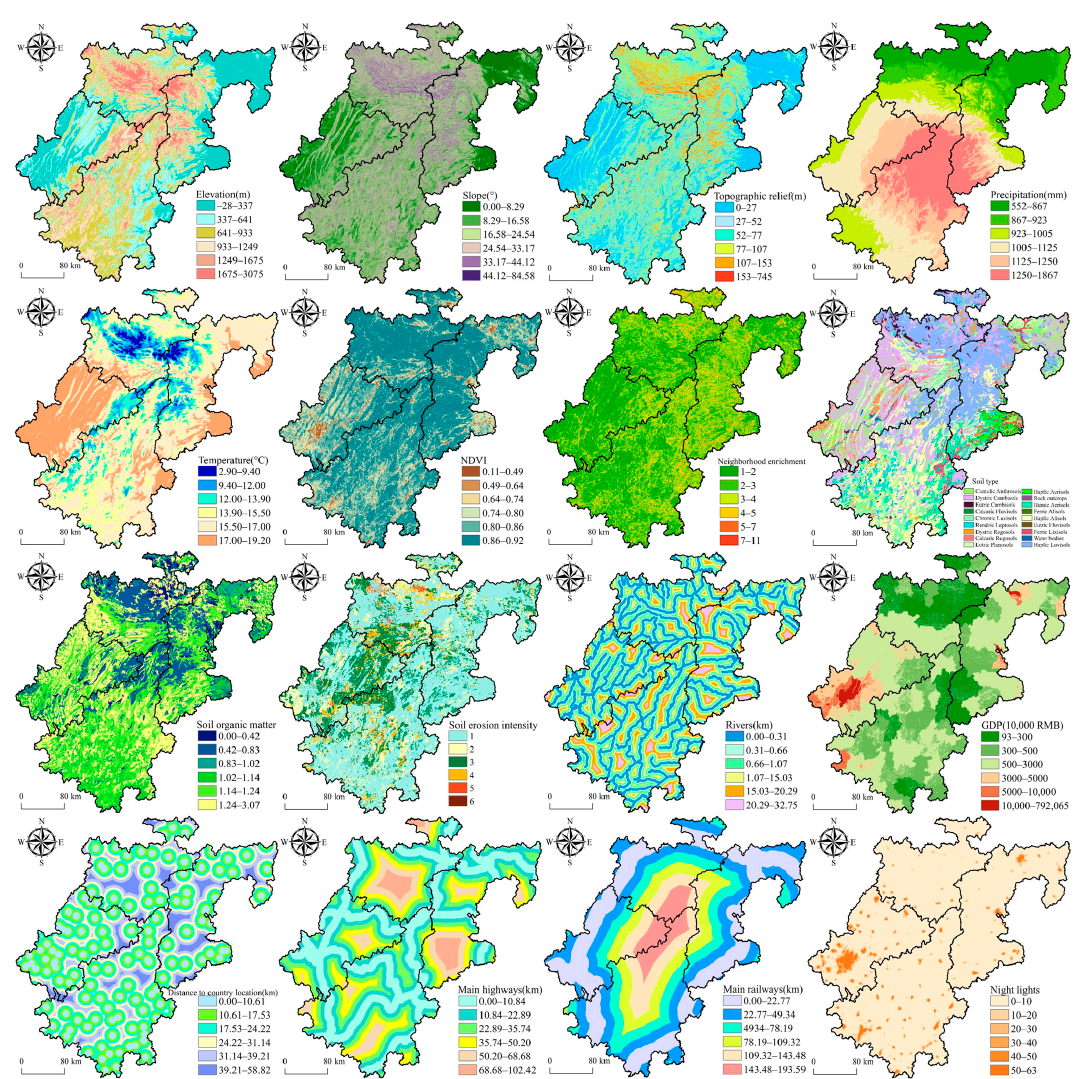
Figure A1. Influencing factors in the study area. Note: The soil erosion intensity scale is divided into six levels: slight erosion (1); mild erosion (2); moderate erosion (3); strength erosion (4); extreme strength erosion (5), intense erosion (6).